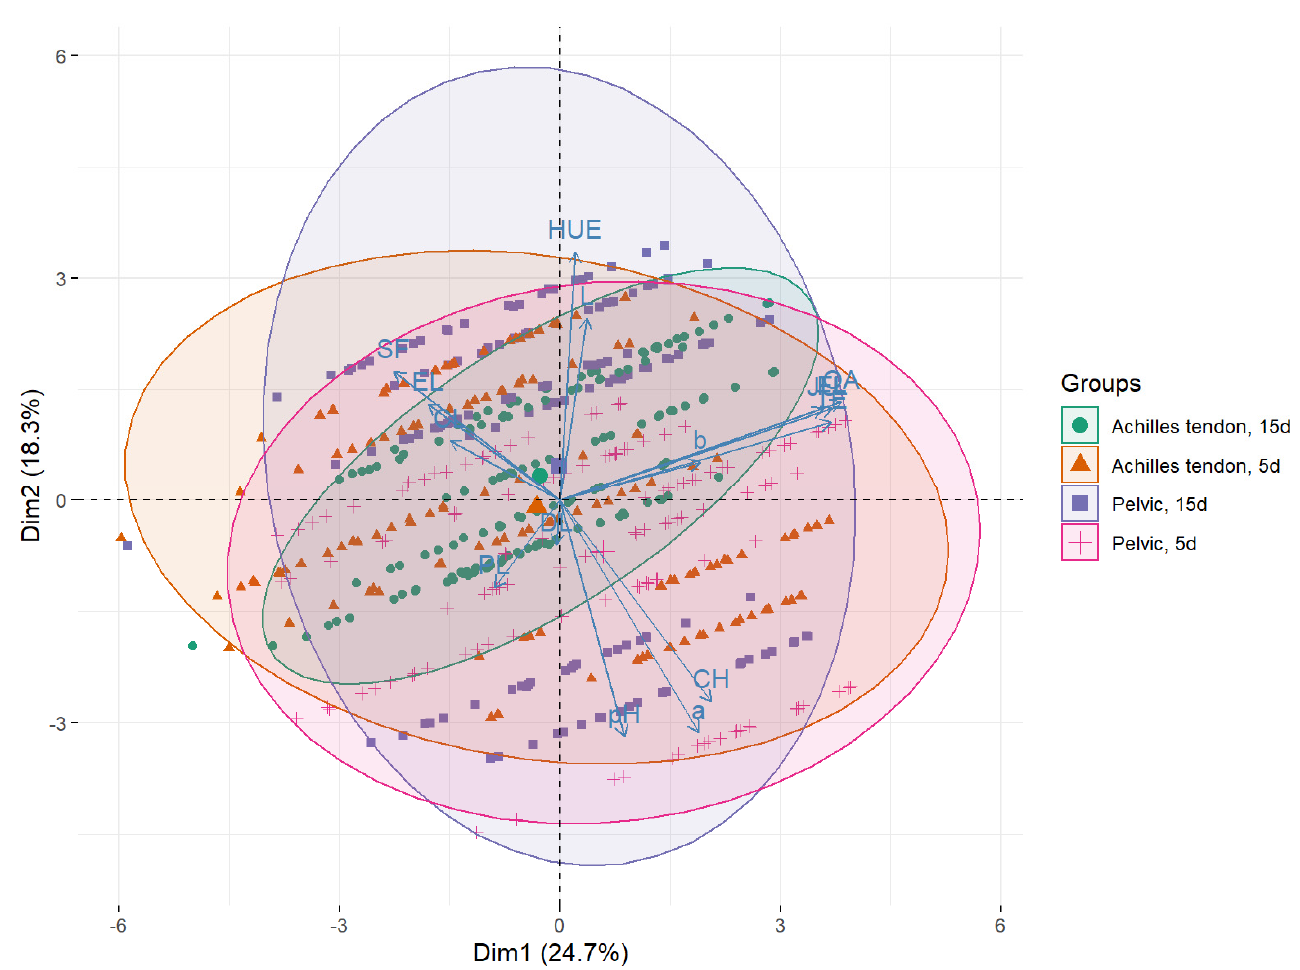
Figure 4. Score plot of meat quality data of Brangus heifers in the multivariate space defined by principal component analysis. PC1 “tenderness” (explained variance: 24.7%) × PC2 “meat color” (explained variance: 18.3%). Group symbols represent both the carcass-suspension method and meat aging period, respectively: ● (Achilles tendon; 15 days), ▲ (Achilles tendon; 5 days), ■ (Pelvic, 15 days) and + (Pelvic, 5 days). The centroid value of each treatment is represented by a larger shape size.